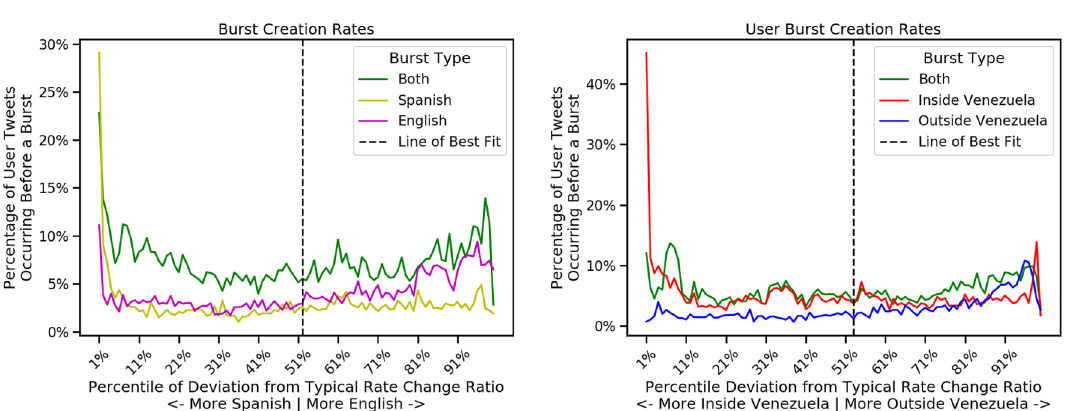
Figure 9. We put our users into percentile bins based on their distance from the typical ratio of rate change within each pair of communities (their distance the line of best fit in Fig. 7). For each group of users by percentile bin, we show the mean percent of these users’ tweets that precede bursts of each type (single community or across